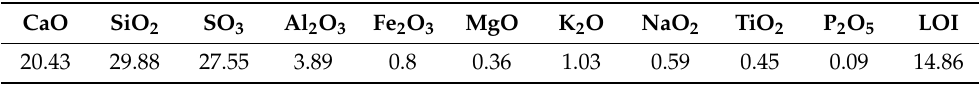
Table 4. Oxide composition of the surface layer of AASC samples after 180 days of exposure to acid (weight